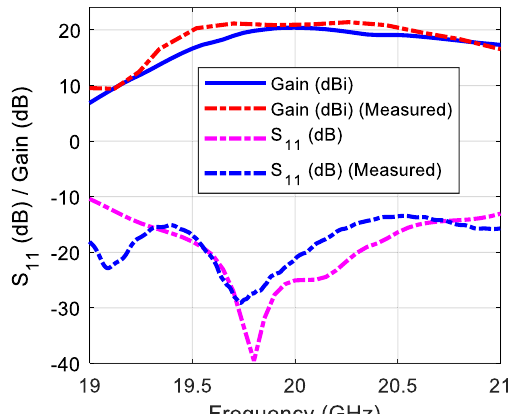
Figure 25. Gain and S 11 of the proposed structure.